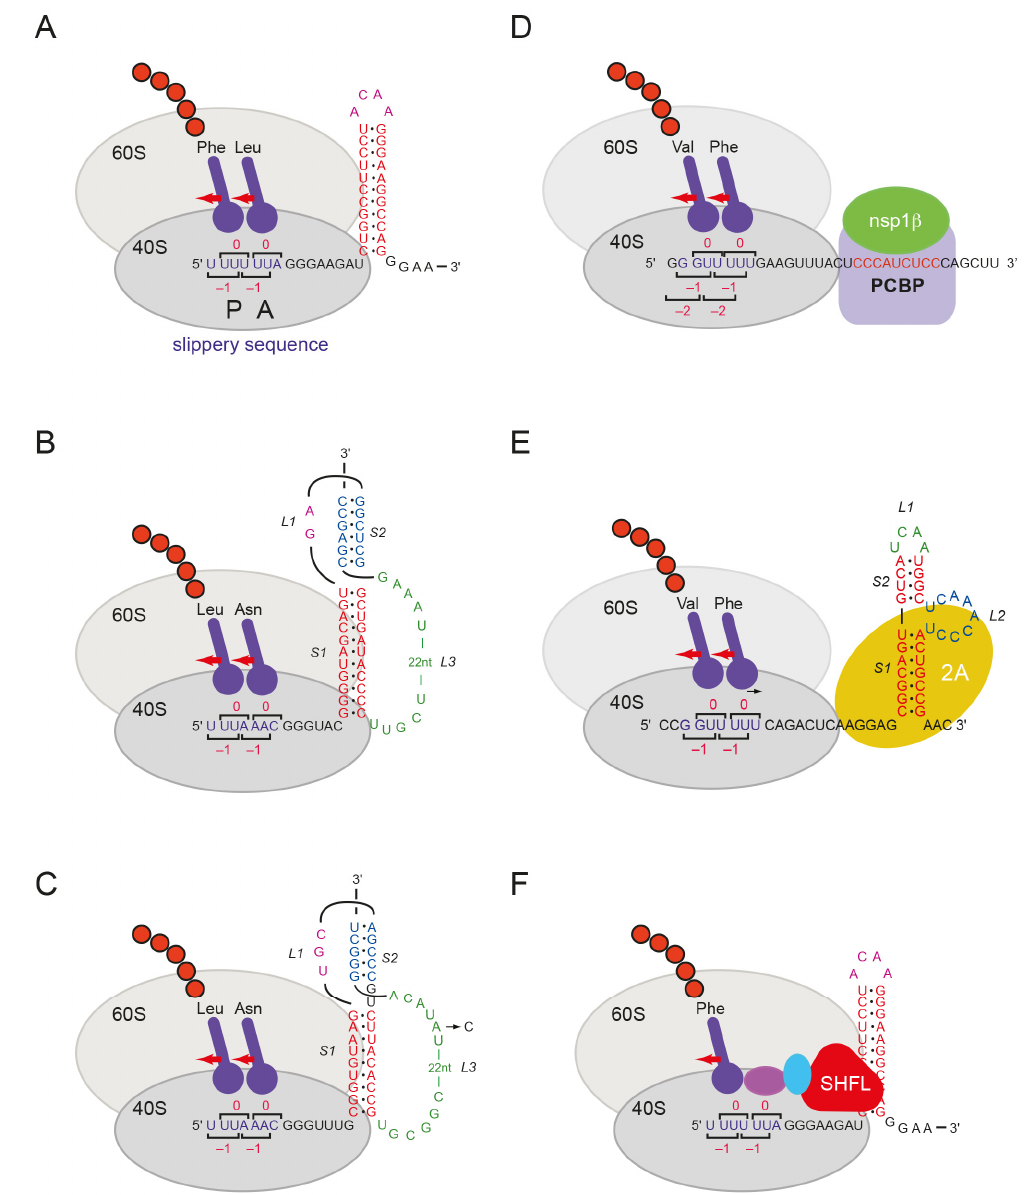
Figure 1. Modulators of programmed –1 ribosomal frameshifting. Cartoon drawings of ribosomes encountering sites of PRF. Stimulators : ( A ) HIV stem-loop; ( B ) IBV pseudoknot; ( C ) SARS-CoV-2 pseudoknot (SARS-CoV sequence identical in the region shown except for an ( A ) to ( C ) transversion in loop 3 (L3) as indicated); ( D ) PRRSV complex of virus (nsp1 β ) and host protein (PCBP); ( E ) Cardiovirus (EMCV) stimulatory RNA complexed with viral 2A protein. Repressor : ( F ) SHFL shown bound at the HIV-1 signal. Purple and cyan ovals represent eRF1 and eRF3 (in complex).